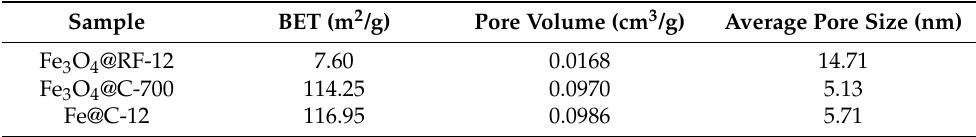
Table 1. Pore performance data of samples before and after